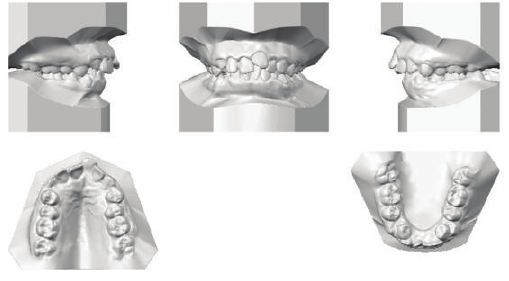
Figure 2: Initial